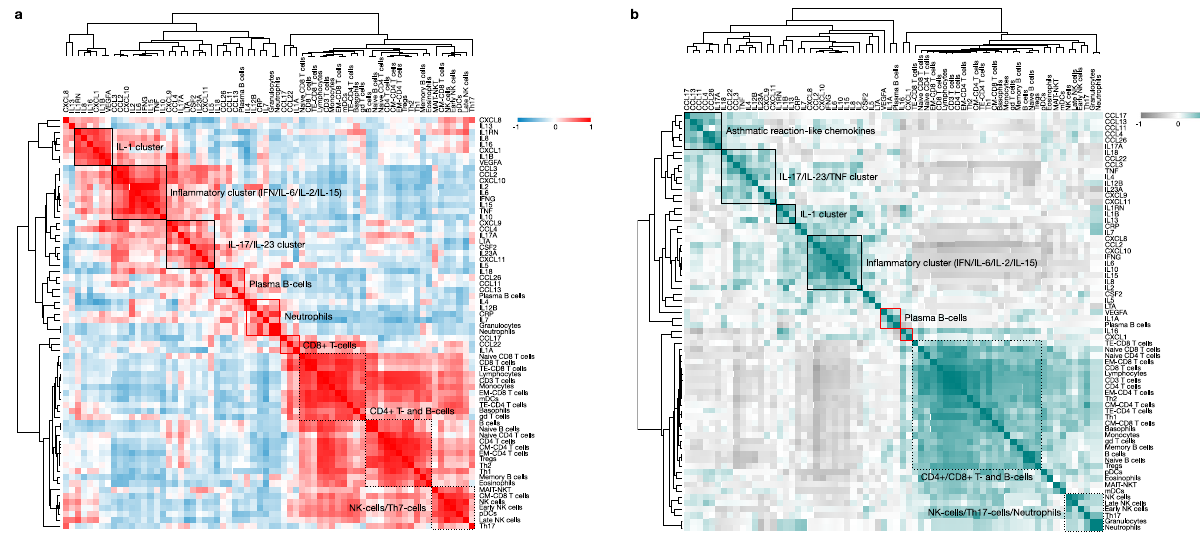
Fig. 4 Disturbed immune regulation in severe COVID-19. Pearson correlation-driven similarity/correlation matrix analysis of cytokines/chemokines and mass cytometry data in critical ( n = 14) ( a ) and mild-moderate ( n = 31) ( b ) COVID-19 patient subgroups. This correlation matrix analysis is a form of statistical modelling by which statistically stable relationships between the different variables (i.e. cytokines/chemokines and immune cell subpopulations) allows their categorization into different clusters indicating high levels of correlation (indicated by the clustering dendrograms). Of note, the diagonal correlation value is 1, which denotes the highest possible statistically signi fi cant correlation value between the given variables and represents the highest comparative threshold that “ centers ” the correlation network. See also Fig. S3. Source data are provided as a Source data fi